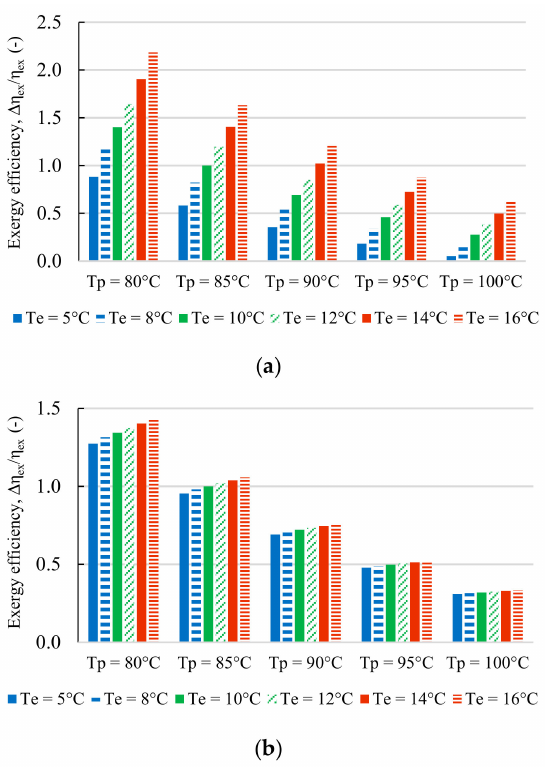
Figure 11. Sensitivity of the refrigeration sub-system exergy efficiency to the evaporator and primary flow inlet (generation) temperatures for the simple Ejector A cycle and compression-assisted Ejector C cycle with R245fa as the working fluid, normalized to a baseline exergy efficiency of T p = 85 ◦ C and T e = 10 ◦ C: ( a ) Ejector A (SC); ( b ) Ejector C